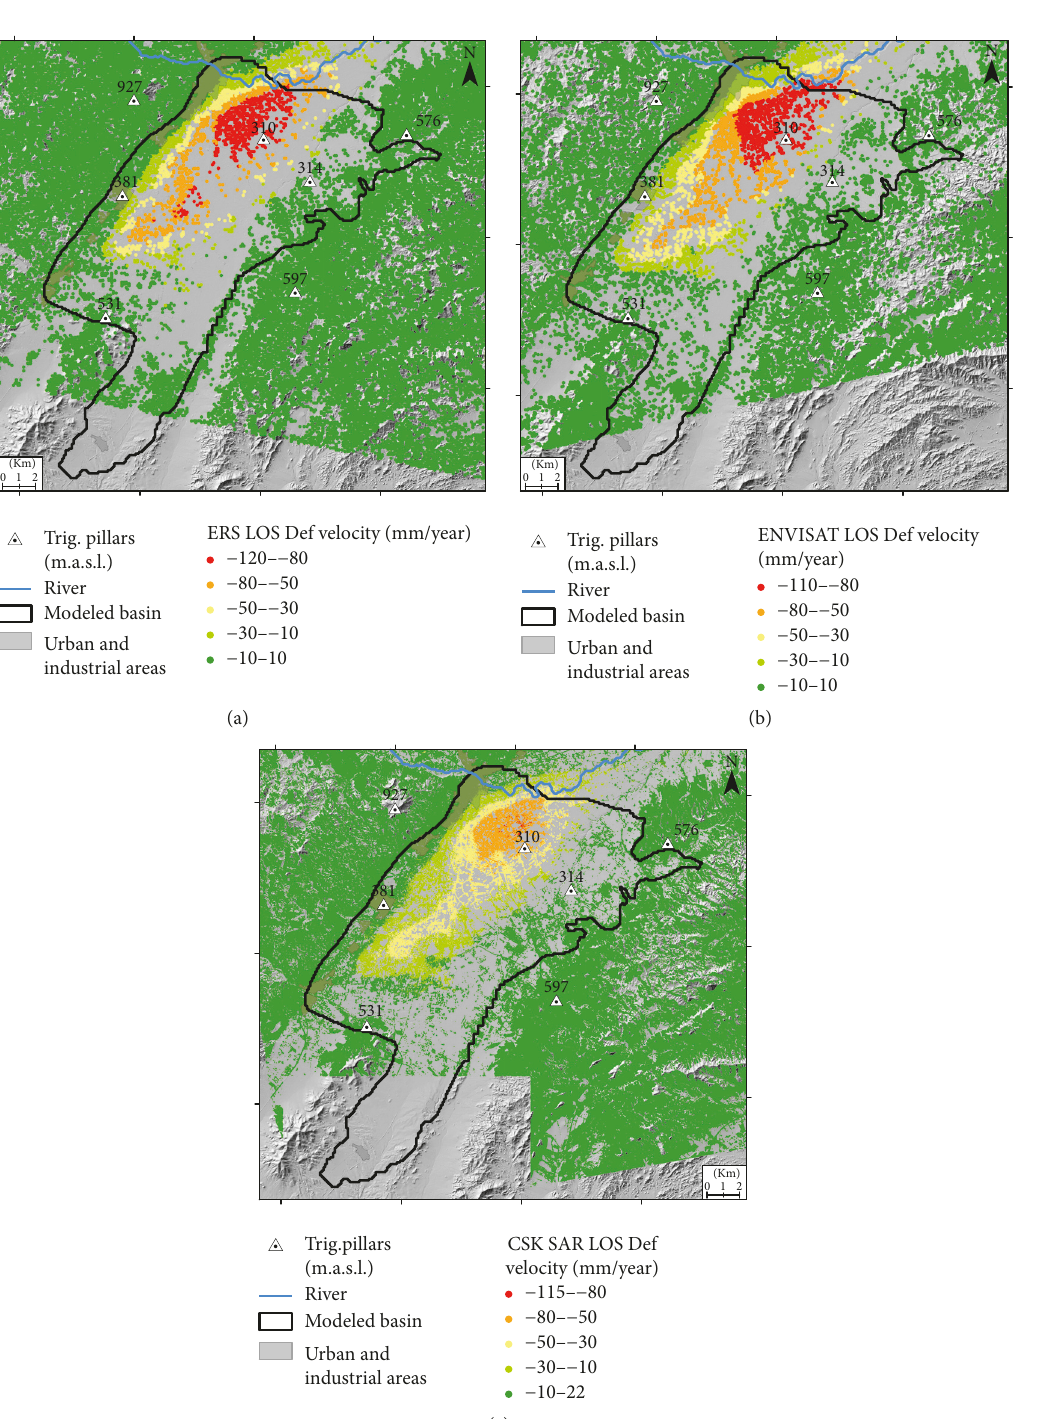
Figure 5: InSAR-derived deformation used in this study. LOS deformation velocities from (a) ERS data (C-band, 1992–2000), (b) ENVISAT data (C-band, 2003–2010), and (c) Cosmo-SkyMed data (X-band,